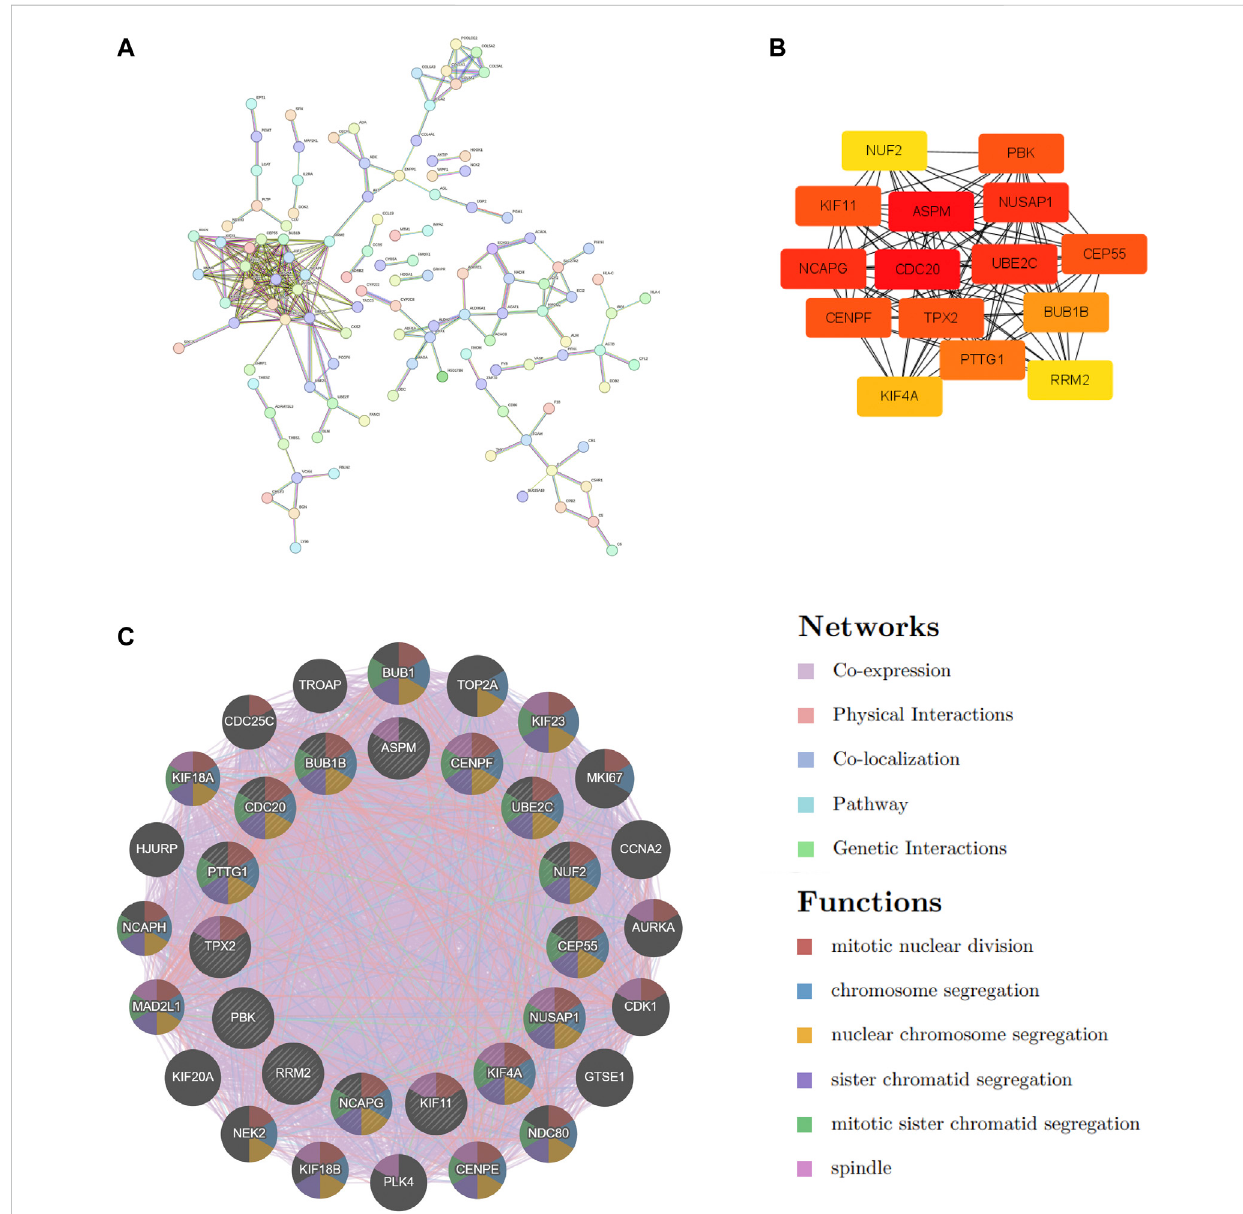
FIGURE 3 PPI Network Construction and hub genes extraction. (A) COVID-19 and ALF common DEGs in the PPI network constructed by STRING. (B) The top 15 hub genes and their interactions with each other. (C) The gene – gene interaction network was visualized by the GeneMANIA database. The top 20 mostly related neighboring genes are shown in the outer circle of hub